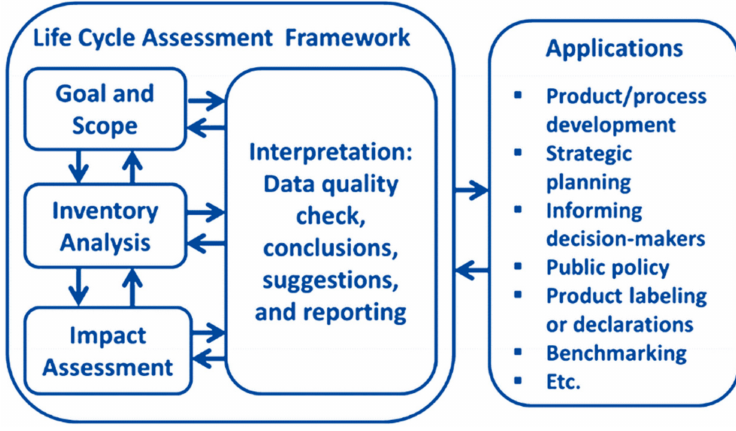
Figure 3. Life Cycle Assessment Framework Structure (Source: